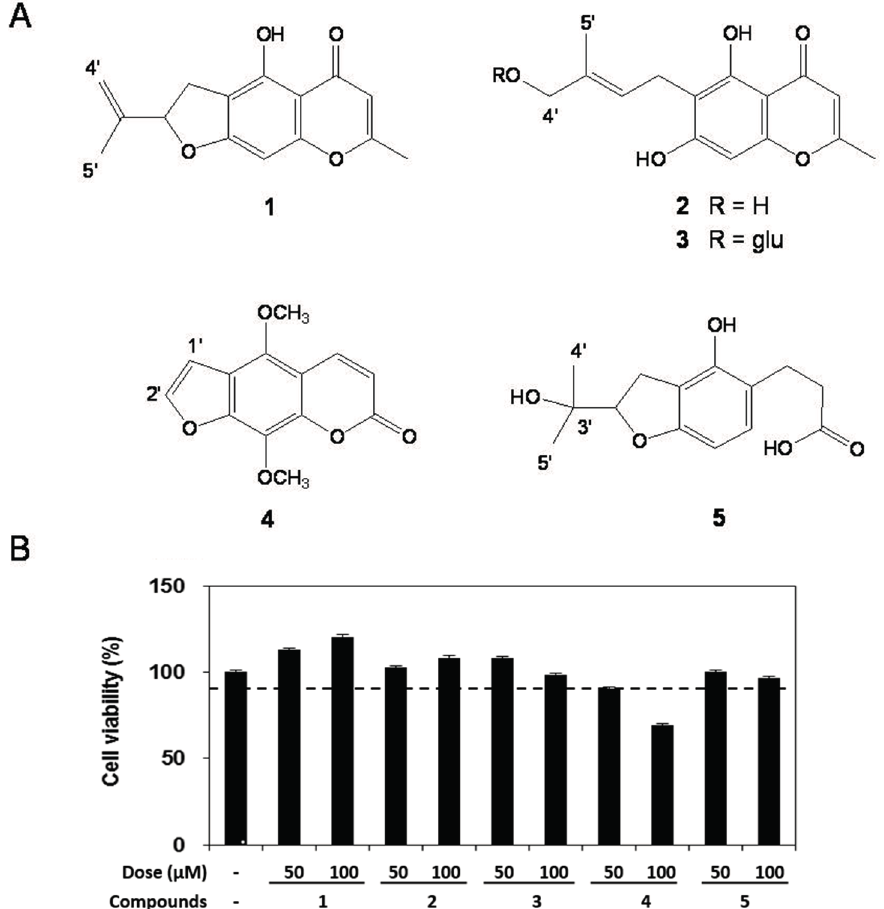
Figure 1. Chemical structure ( A ) and effect on cell viability ( B ) of compounds 1 – 5 isolated from Corydalis heterocarpa on RAW 264.7 cells. RAW 264.7 cells were treated with 50 and 100 μ M of compounds 1 – 5 for 1 h prior to the addition of LPS (100 ng/mL), and the cells